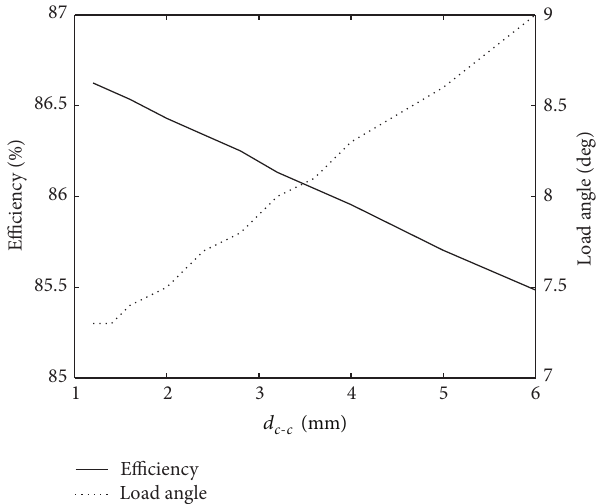
Figure 4: The efficiency and the load angle as a function of the distance between